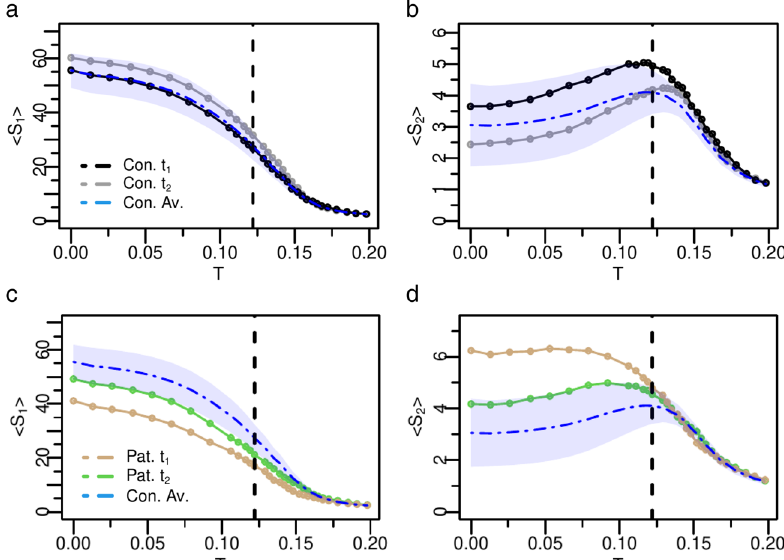
Fig. 2 Fingerprints of criticality loss and associated recovery in a representative patient. Analysis of neural activity patterns, S 1 and S 2 , of a healthy participant (Con. / a , b ) and stroke patient (Pat. / c , d ). In blue dashed line we show the corresponding control's group average, while the shaded area corresponds to one standard deviation. For the healthy participant, t 1 and t 2 correspond at two different time points 3 months apart. For the patient, t 1 and t 2 correspond to 3 months and 12 months post-stroke. The healthy participant exhibits features of criticality at both time points with small variability across time points and within the variability of the healthy group. At the same threshold T , both S 1 and S 2 sharply change their size. For the stroke patient under consideration, the fl attened shape at t 1 of both, S 1 and S 2 , combined with the monotonic behavior of S 2 indicates lack of criticality, which, however, returns at t 2 as depicted by the emergence of a peak in S 2 . The black vertical dashed line depicts the critical point of healthy controls. Source data are provided as a Source Data fi le.